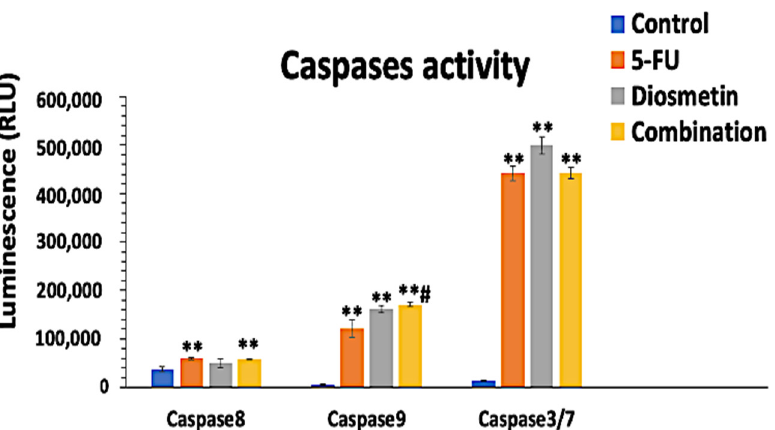
Figure 14. Caspase 8, 9, and 3/7 activities induced by monotherapy and combination therapy in HCT116 cells. Estimation was measured using luminescence analysis at 27 h treatment. Data are presented as mean ± SD. ** p < 0.01 indicates a significant difference compared with the control cells (untreated). # p < 0.01 indicates a significant difference between the combination-treated cells and the 5-FU-treated cells.